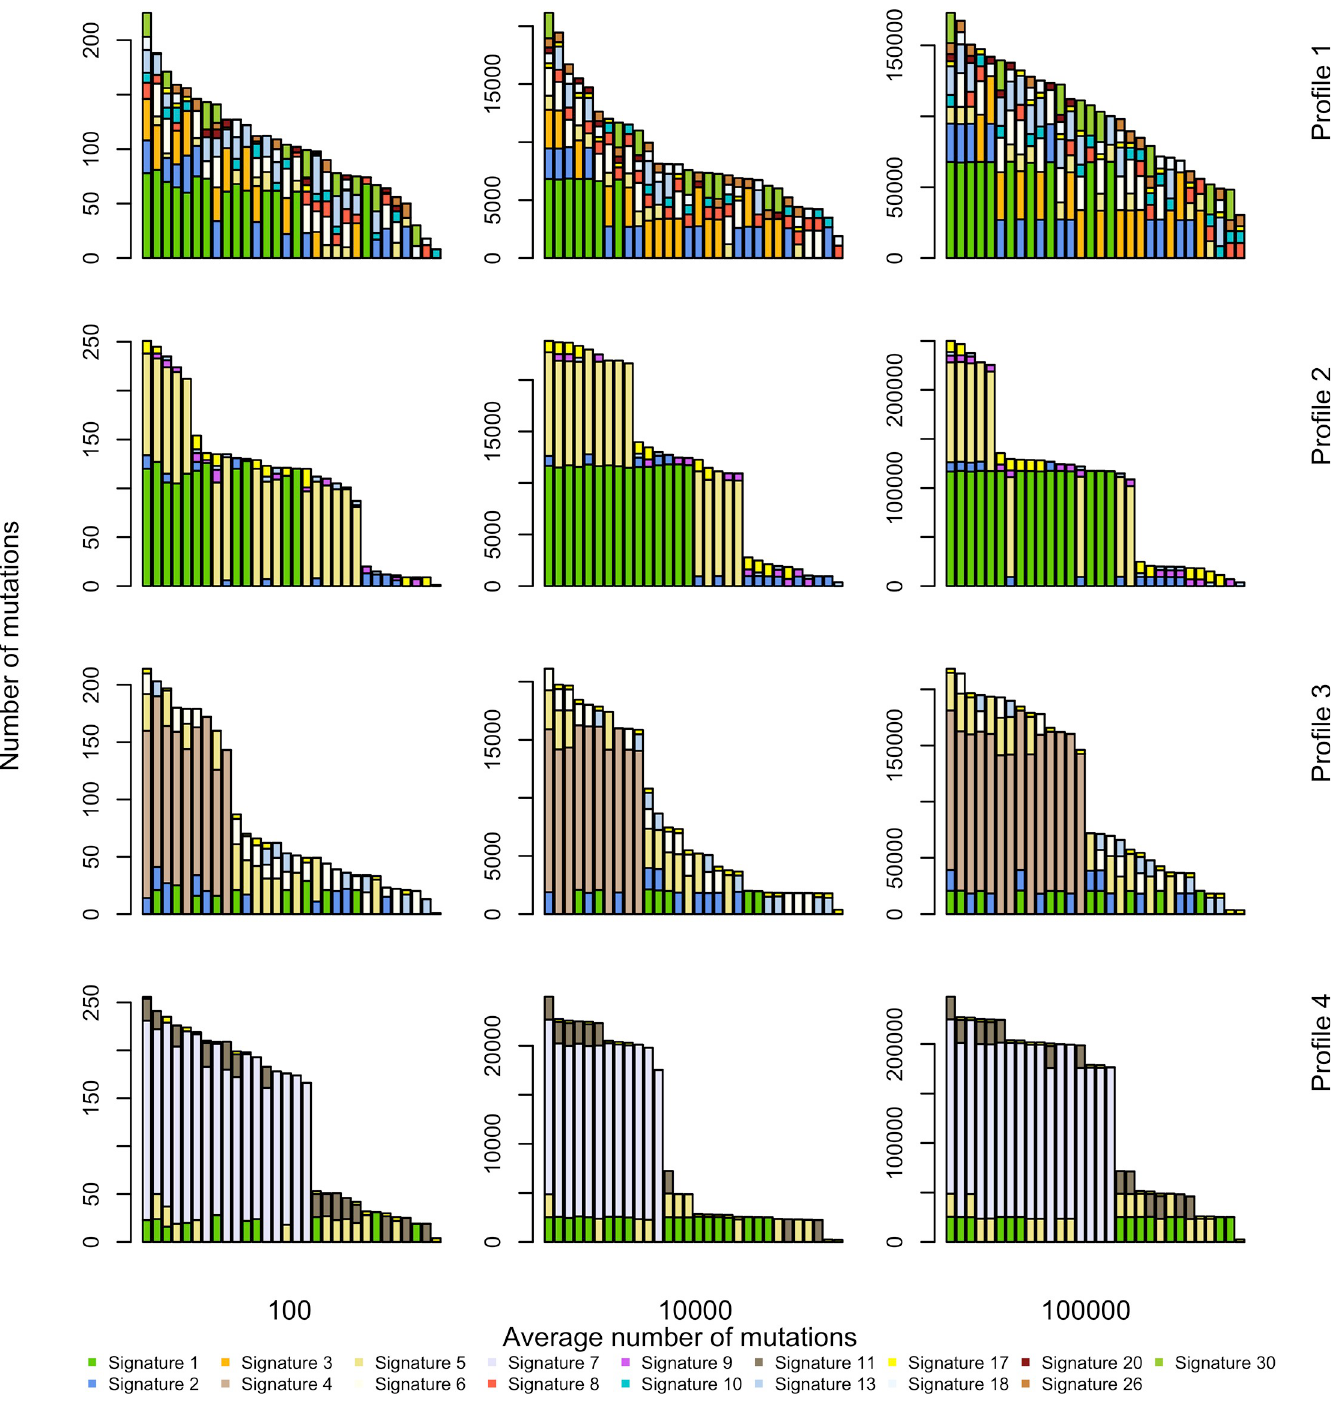
Fig 2. Sample of simulated catalogues. Catalogues are simulated according to the model described in the text. Tuning parameters are the average number of mutations, here r = 10 2 ,10 4 and 10 5 , and the cancer type-specific average contribution of each signature (also see S4 Fig). Coloured bars indicate the contribution of each signature to the total mutational load of each